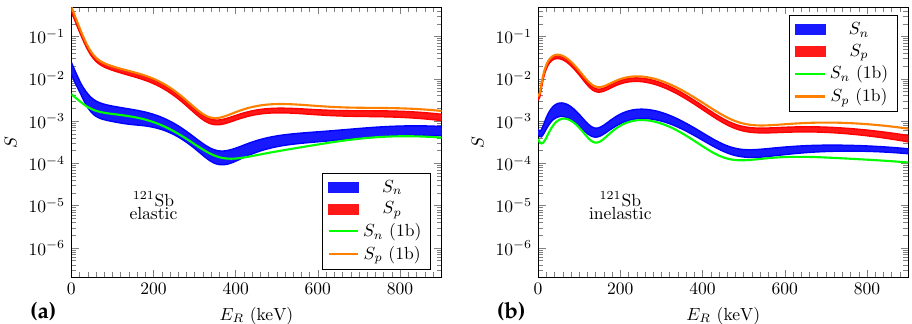
Figure 3. Structure functions of nucleus 121 Sb: ( a ) Left panel shows neutron-only and proton-only structure functions in the case of elastic scattering (nucleus remains in the ground state 5/2 + ). ( b ) Right panel shows neutron-only and proton-only structure functions in the case of inelastic scattering (nucleus excites to the first excited state 7/2 + ). S n , p (1b) are with one-body currents